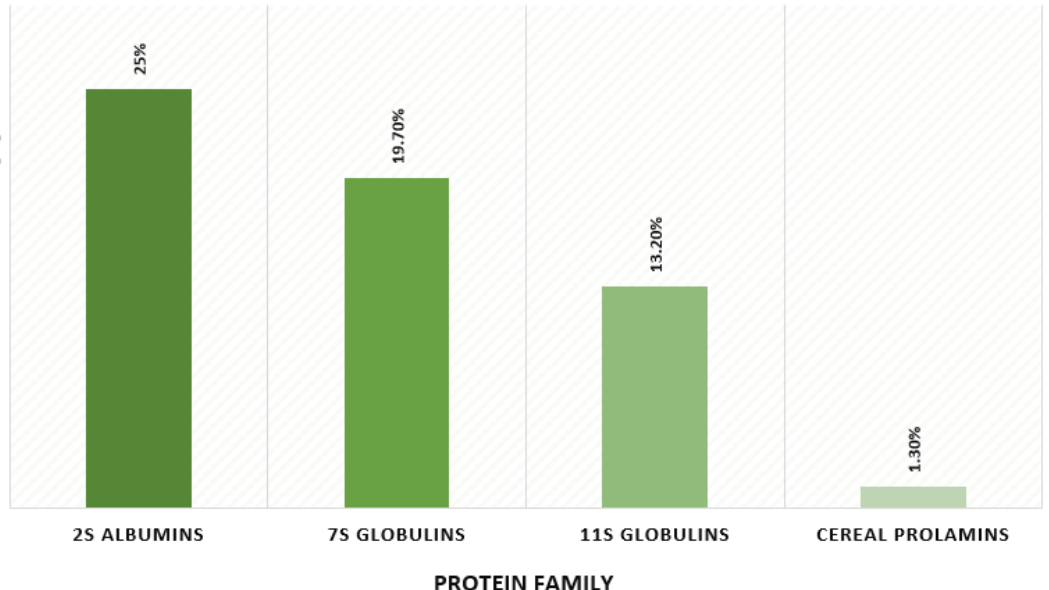
Figure 1. Prevalence of sensitisation to 2S albumins, 7S globulins, 11S globulins and cereal prolamins in atopic children aged 0–5 years. Table 1. Results of Allergy Explorer ALEX2.